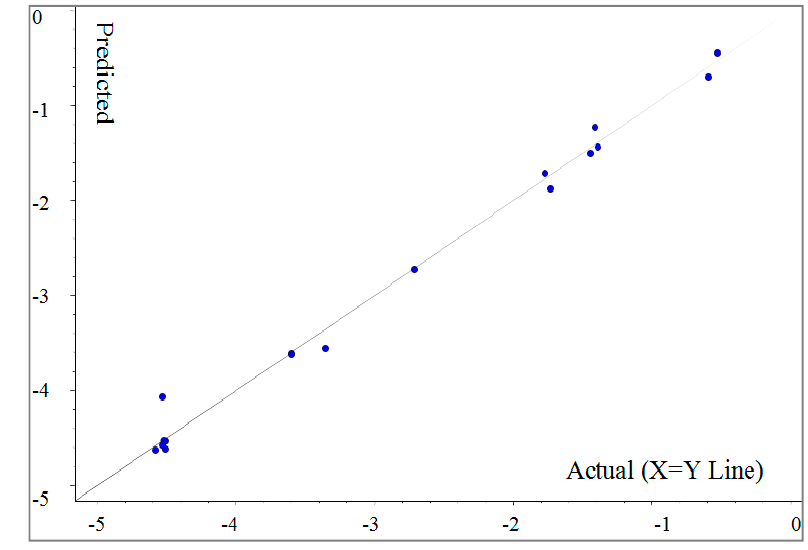
error of estimate, F: the Fischer ratio.